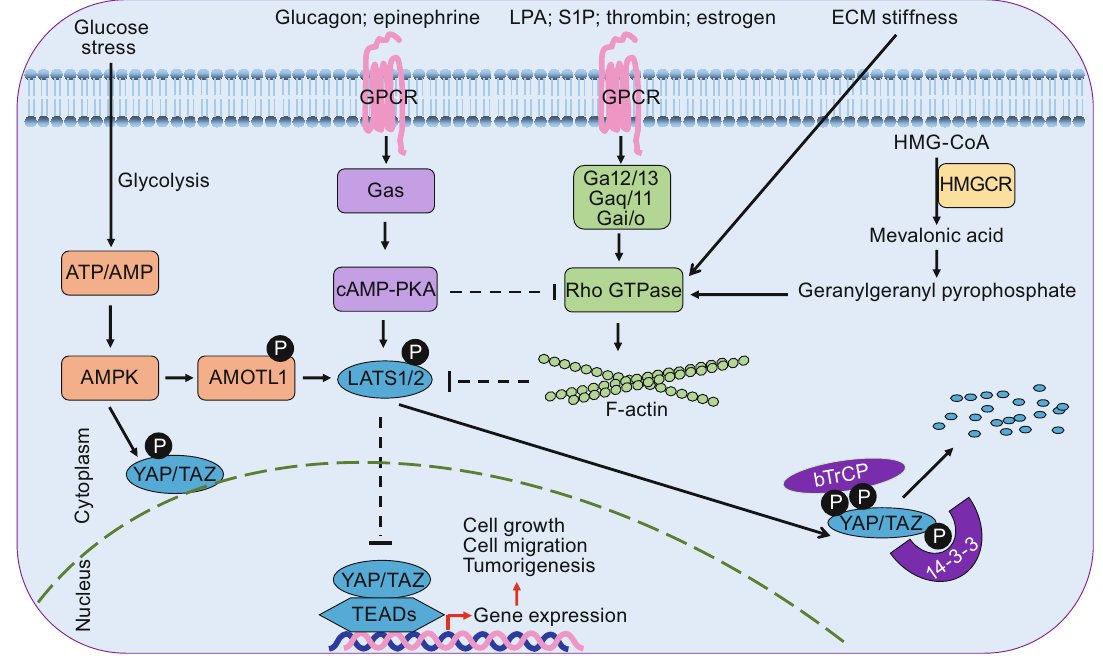
Figure 2. Regulation of the Hippo pathway by multiple upstream signals. G α q/11-, G α 12/13-, and G α i/o-coupled GPCRs signals activate YAP/TAZ via promoting Rho GTPase activation and cytoskeleton assembling, leading to the inhibition of LATS1/2 kinase activity; while G α s-coupled GPCRs exert opposing roles on YAP/TAZ activation. The mevalonate cholesterol biosynthesis pathway, which is required for membrane localization and activation of Rho GTPase, promotes YAP/TAZ nuclear localization and activation. Inhibition of the mevalonate pathway is a potential way to target YAP/TAZ in human cancer. Under glucose deprivation condition, AMPK is activated to inhibit YAP/TAZ via direct phosphorylation on YAP/TAZ or via